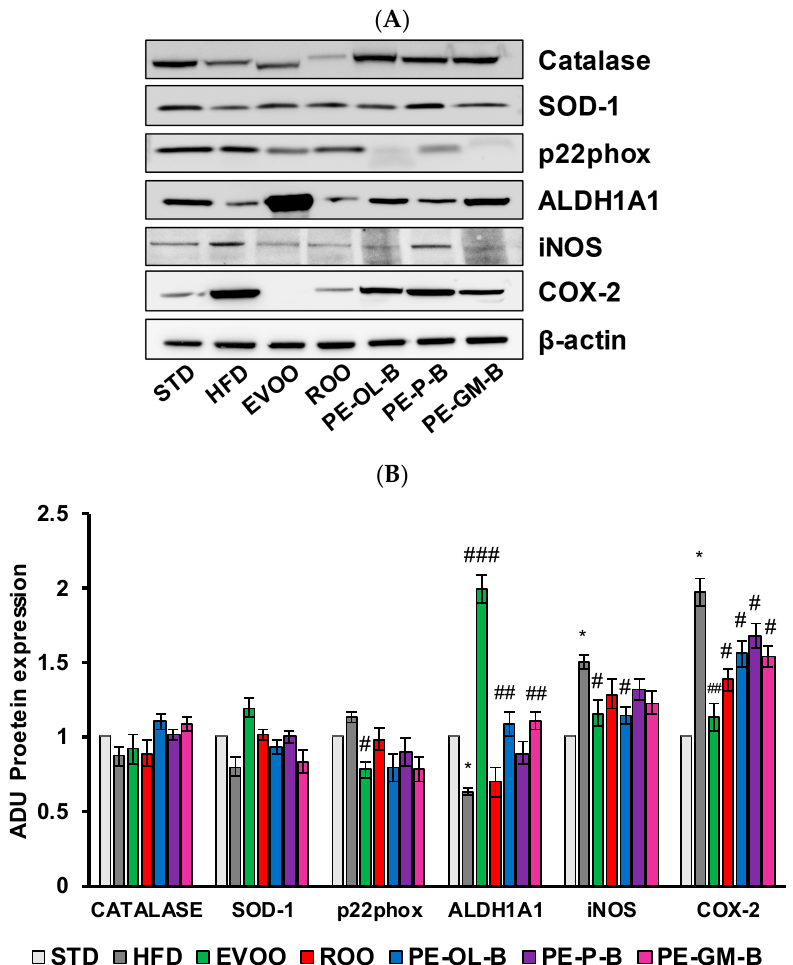
Figure 7. Diet supplementation of HFD fed rats with EVOO, ROO, PE-OL-B, PE-P-B, and PE-GM-B affects the expression of inflammatory and oxidative stress proteins in aortic vessel tissues. ( A ) Western blot analysis of oxidative stress factors (Catalase, SOD-1, p22phox, and ALDH1A1) and inflammatory factors (iNOS, COX-2) in the aorta tissues. ( B ) Quantification of Western blots. Data are determined by ratio of arbitrary density unit (ADU) target protein/ β -actin, and reported as fold change vs. STD which was assigned to 1. Data are means ± SD ( n = 3). * p ≤ 0.05 vs. STD; # p ≤ 0.05; ## p ≤ 0.01 vs. HFD; ### p ≤ 0.001 vs. HFD.